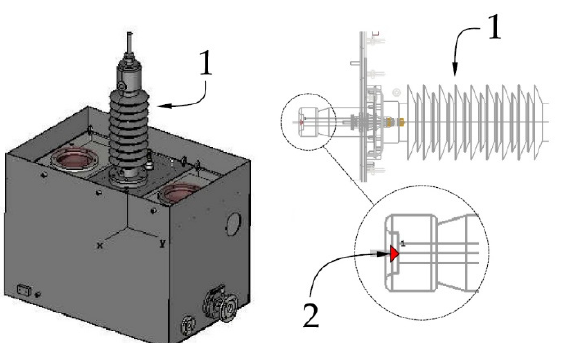
Figure 17. Realistic transformer tank 3D model used in CST-MWS: 1—110 kV transformer bushing; 2—discrete port used in CST-MWS to model the PD source located at the lower terminal of the bushing.